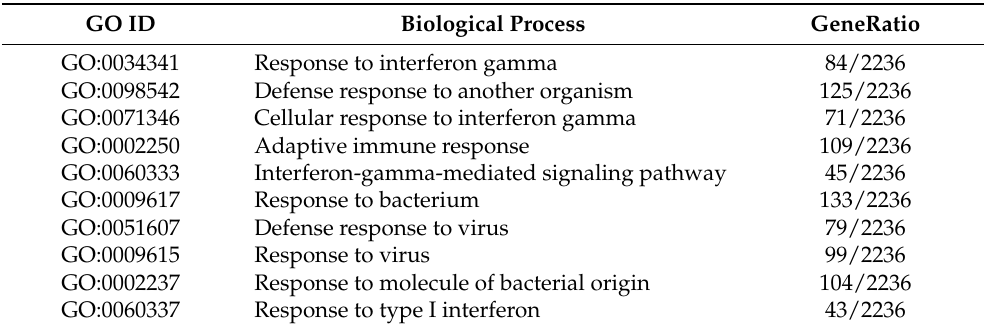
Table 3. Top 10 biological processes significantly (padj ≤ 0.01) enriched in genes differentially expressed in M1_B versus M0_B macrophages.